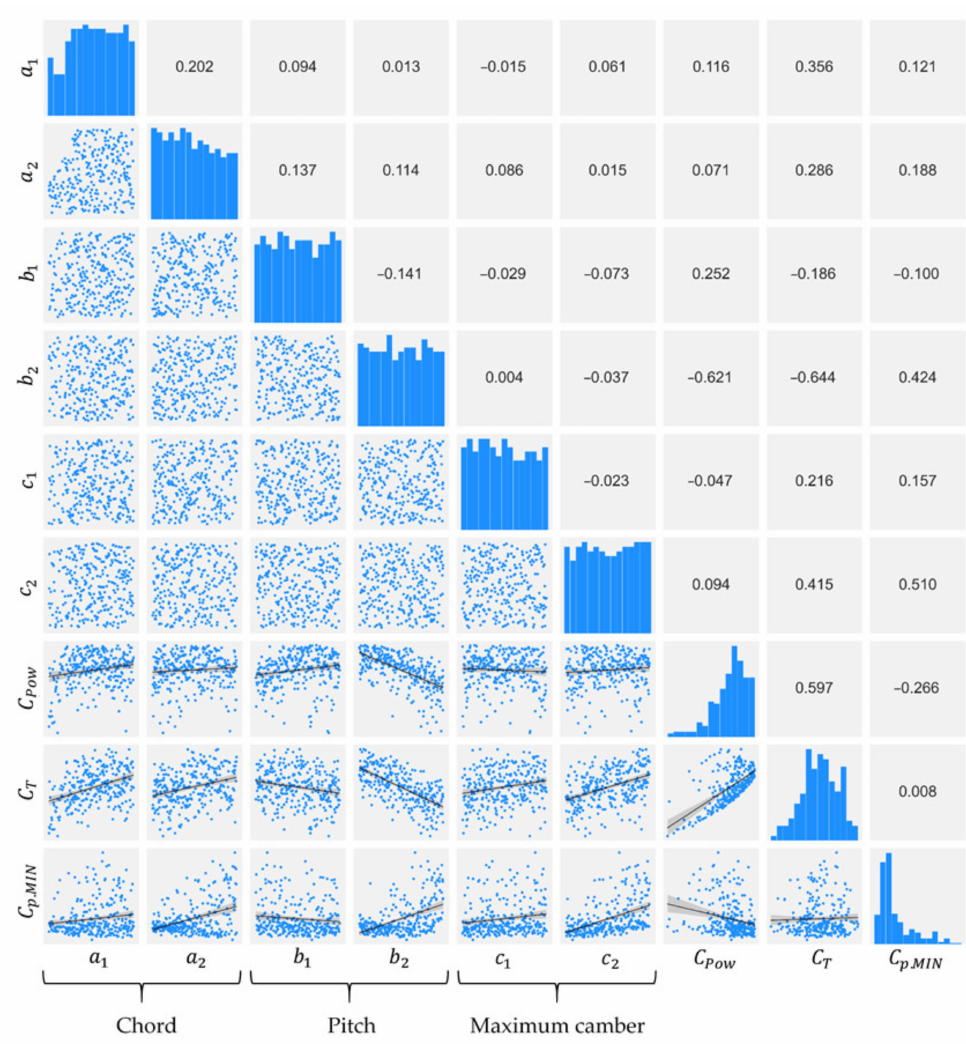
Figure 5. Scatter plot matrix for the data used to build the surrogate